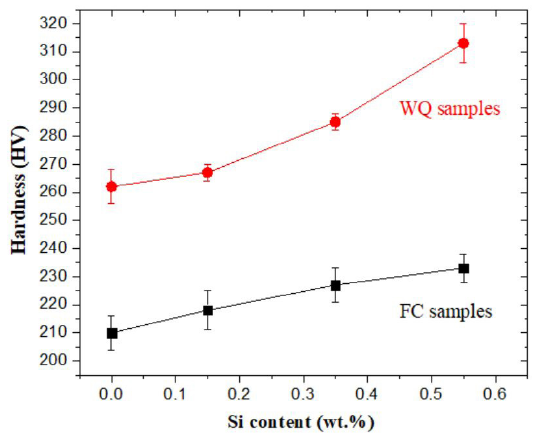
Figure 9. Hardness of solution-treated samples as a function of Si content. FC: furnace-cooled; and WQ: